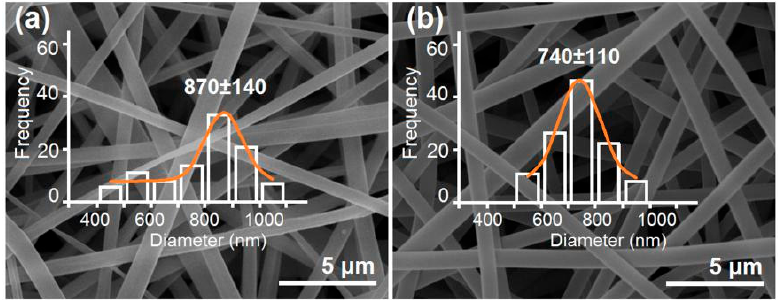
Figure 4. The SEM images of MCFs ( a ) and the CSFs created using the modified triaxial electrospraying ( b ).